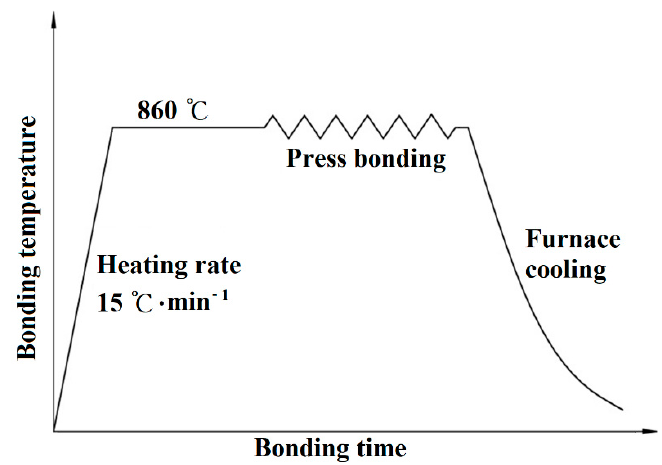
Figure 2. Schematic diagram for the press bonding